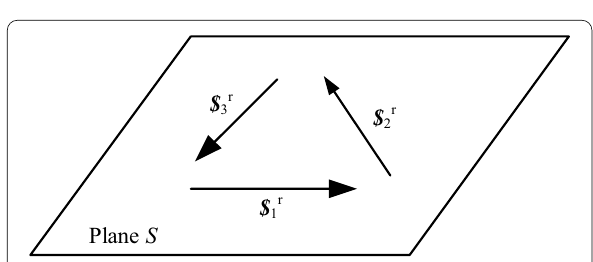
Fig. 3 Distribution of the constraint forces of the moving platform